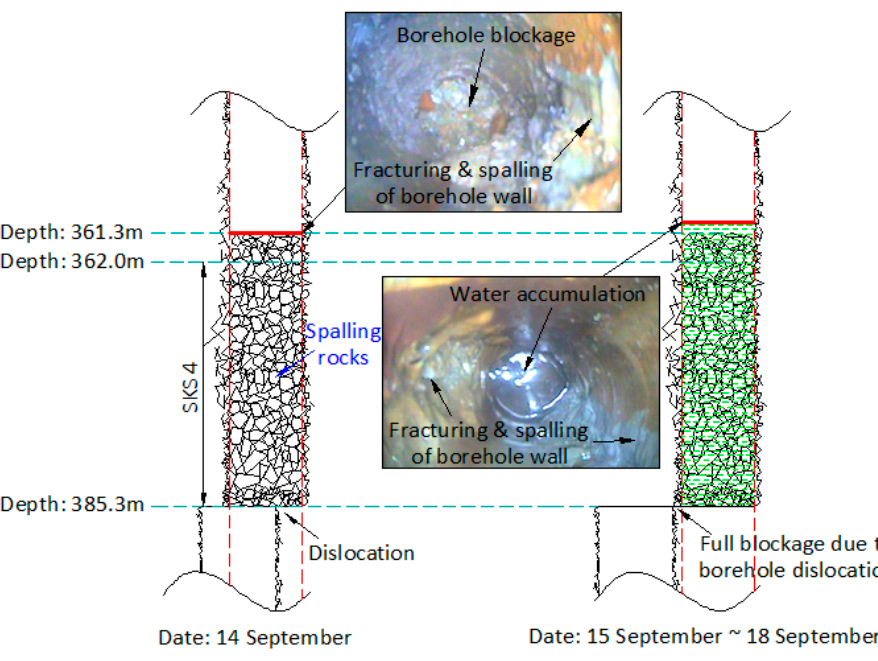
Figure 10. Schematic of water accumulation in the borehole at the depth of 361.3 m.